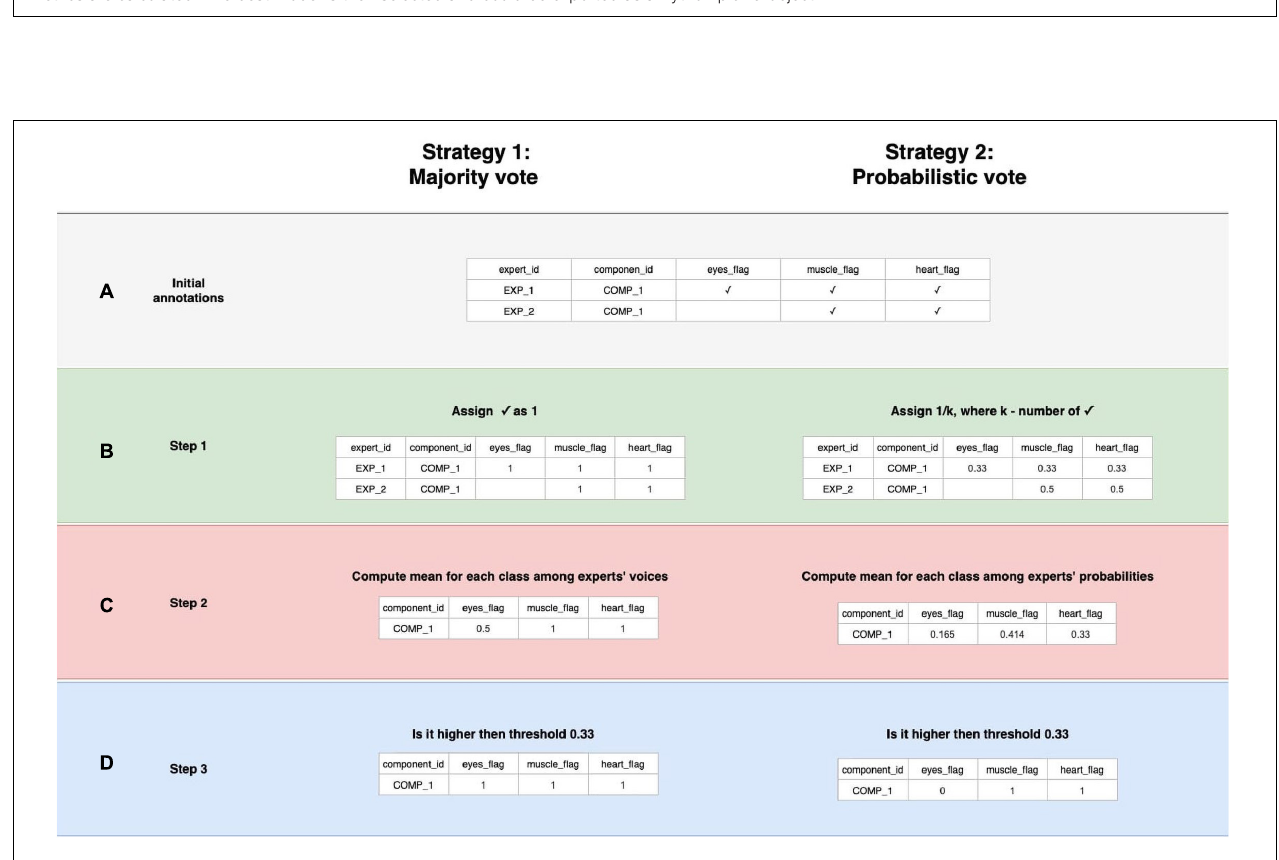
FIGURE 3 | Data processing and machine learning pipeline in ALICE. Raw ICs data with annotations are passed to Data labels aggregation and Feature calculation blocks to form a labeled dataset and extract informative features from ICs. Three ML models are trained with repeated train-test validation and different model quality metrics are calculated. The best model is then selected and could be exported as a Python pickle-object.